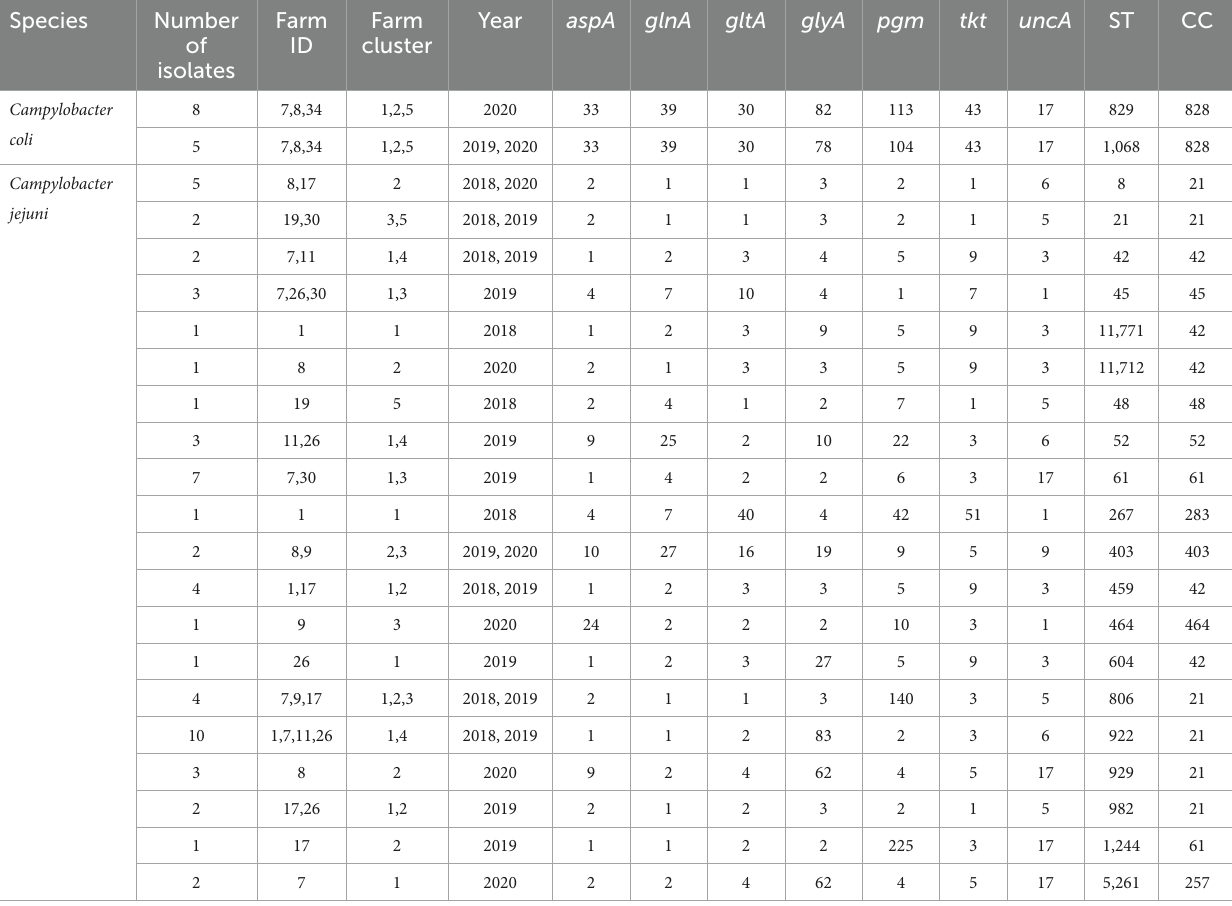
TABLE 3 Multi-locus sequence typing of thermophilic Campylobacter isolates using the traditional seven gene schema.